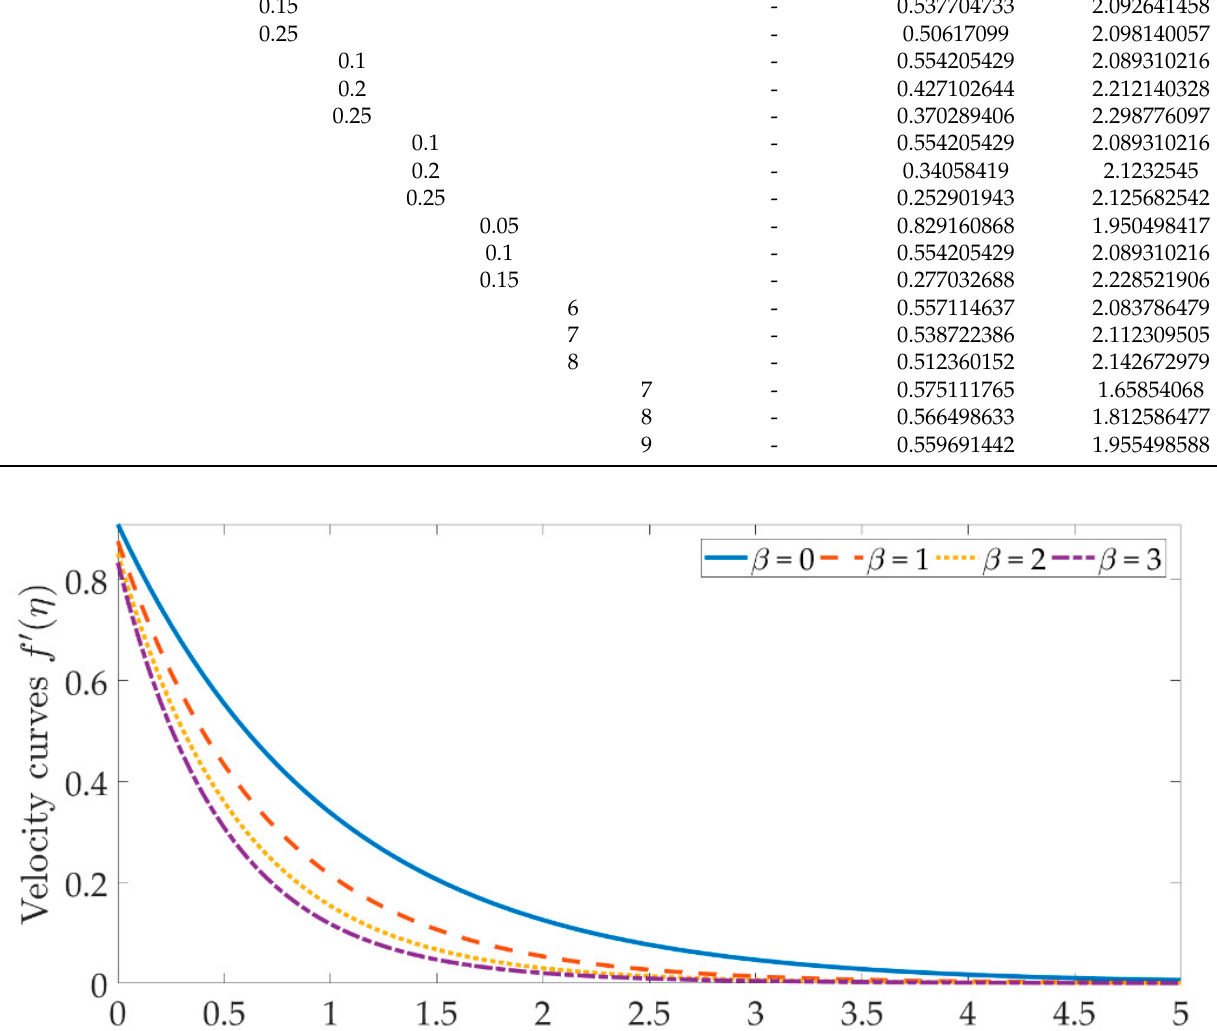
Figure 3. Velocity curves against the multiple values of 1 . f